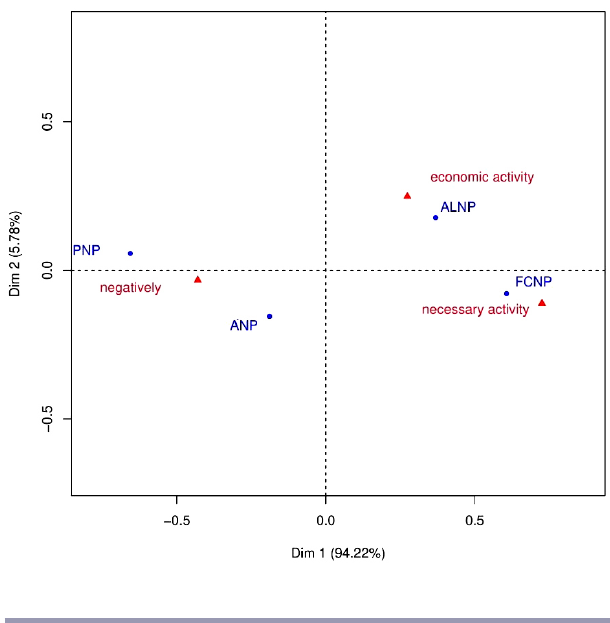
Fig. 5 . Biplot of “parks” (blue) vs “forest” (red) variables. Note: FNCP = Foreste Casentinesi, Monte Falterona e Campigna National Park, ALNP = Abruzzo, Lazio e Molise National Park, PNP = Pollino National Park, and ANP = Aspromonte National